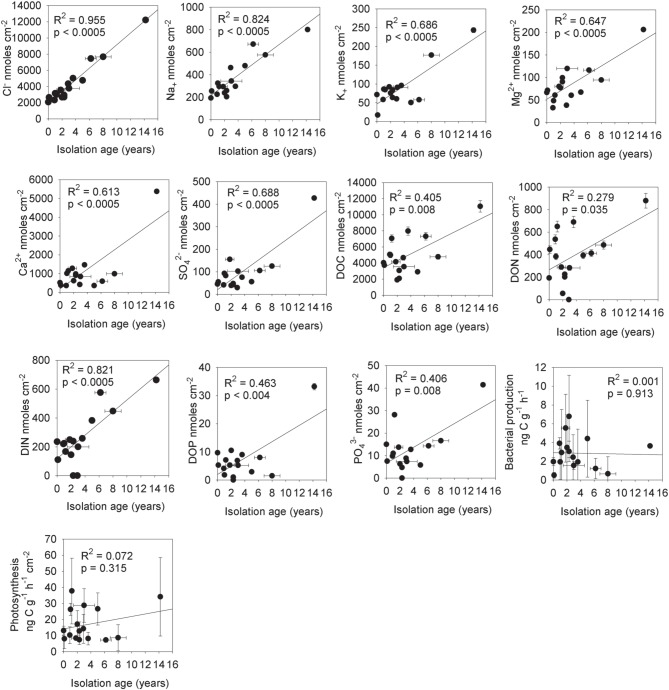
The total mass of aqueous nutrients in cryoconite holes vs. their isolation age from the supraglacial hydrological system (based on chloride mass balance). Statistics are for linear regression analysis, n = 16 (T = 0 and T + 10).